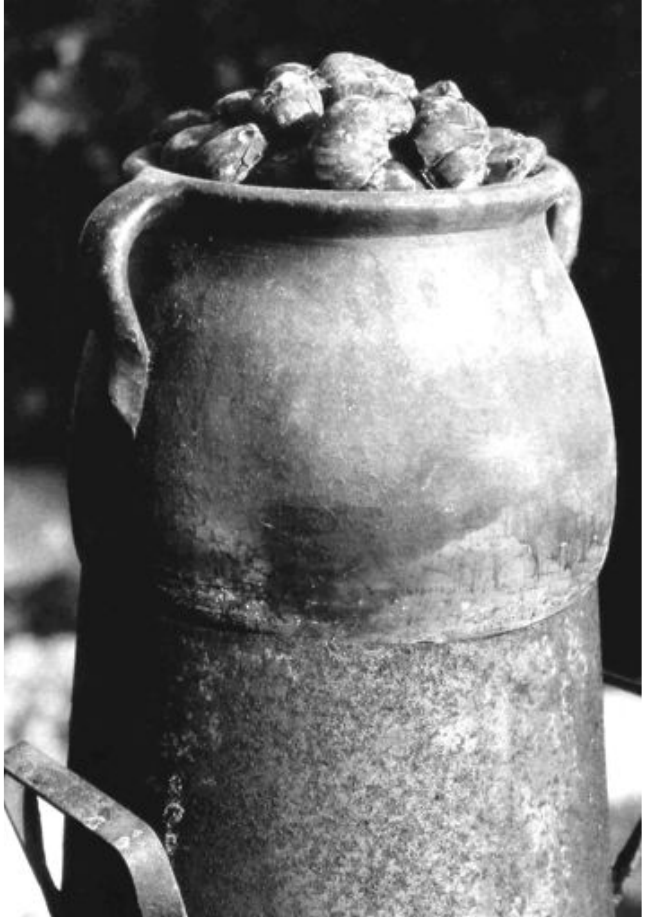
Fig. 9 - Traditional chestnut